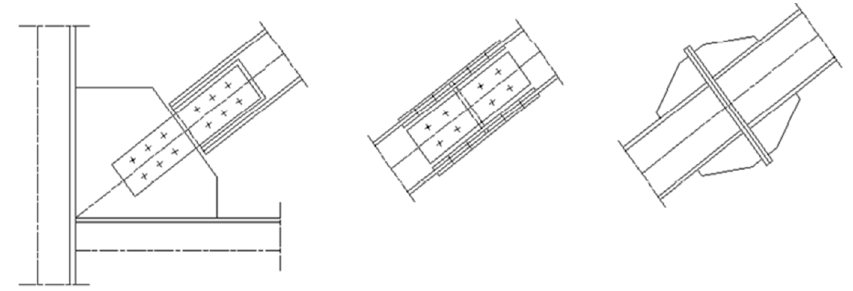
Figure 8. Connections in (predominantly) axially loaded members. From left to right: Web cover plates; Web and flanges cover plates; endplates.